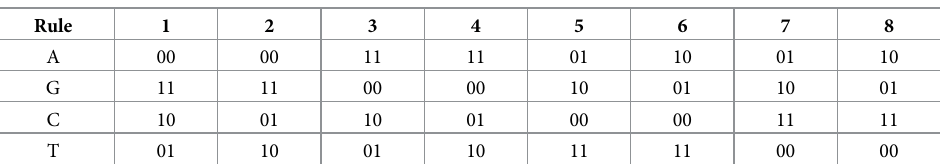
Fig 5. Different curves. A: Continuous raster method. B: Spiral method. C: Diagonal method. https://doi.org/10.1371/journal.pone.0267094.g005 Table 1. DNA encoding rules.